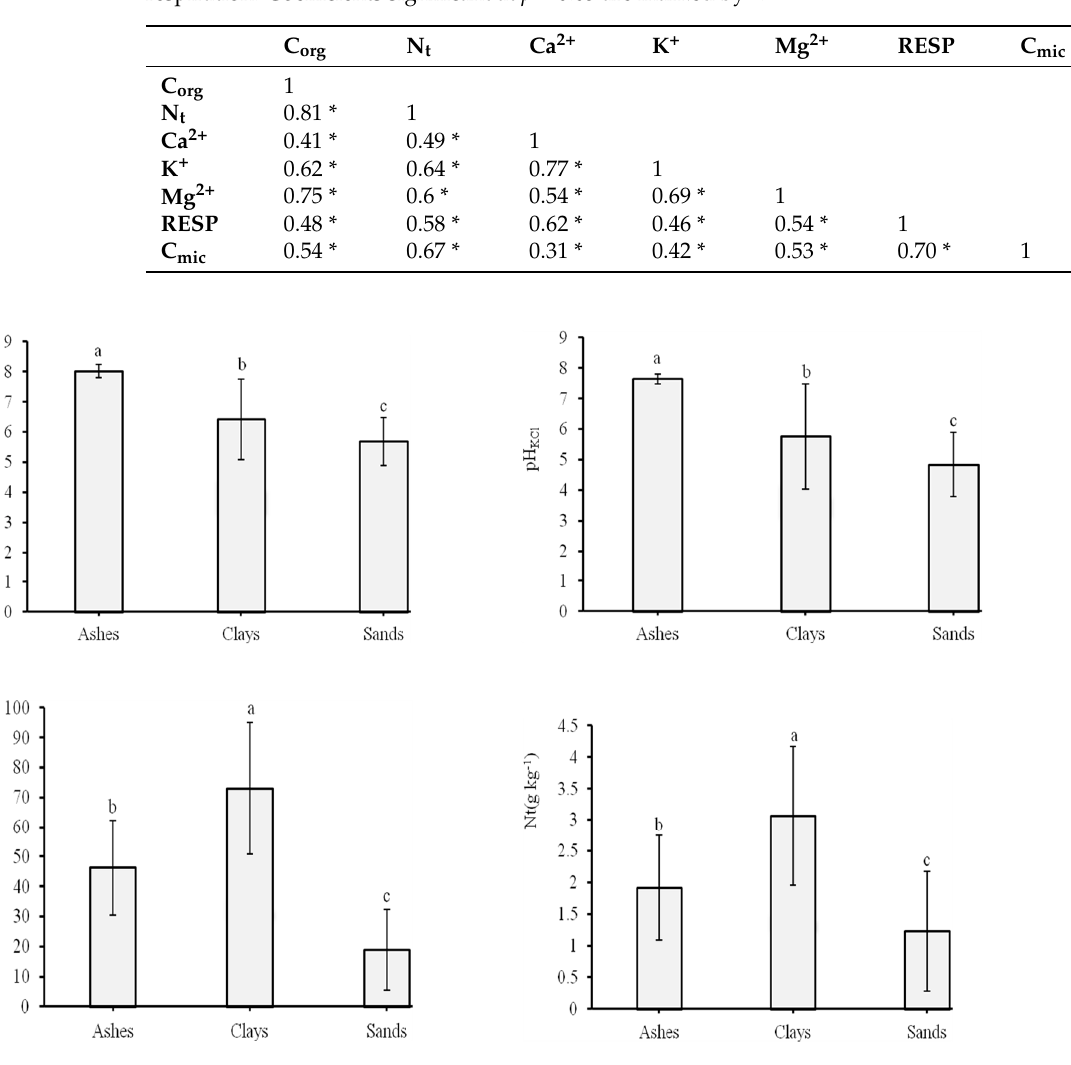
Table 5. Correlation coefficients ( n = 72) between macronutrients content and microbial biomass and respiration. Coefficients significant at p = 0.05 are marked by *.